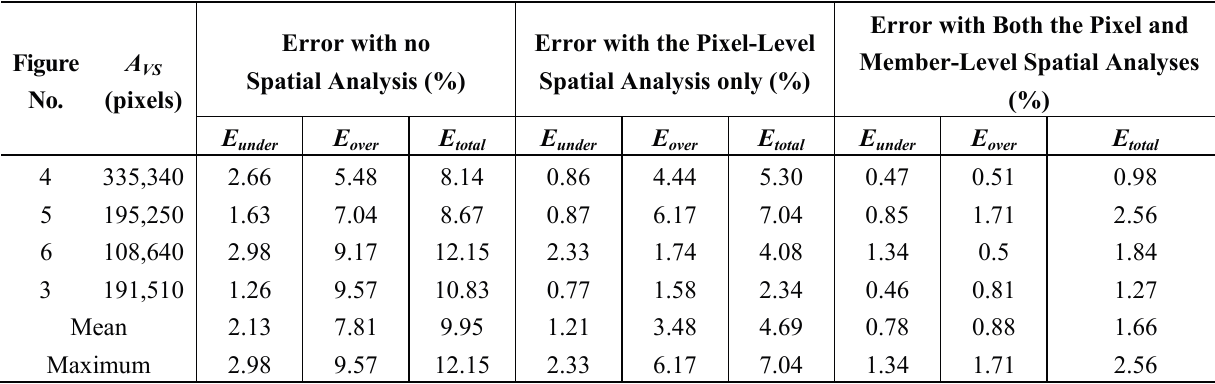
Table 2. Assessment of accuracy of extracting vegetation object. A = ( A / A ) × 100(%) and E vegetation; E under under VS are the area of the false-absent and the false-present, respectively. E A over = E + E maximum error and E total under over